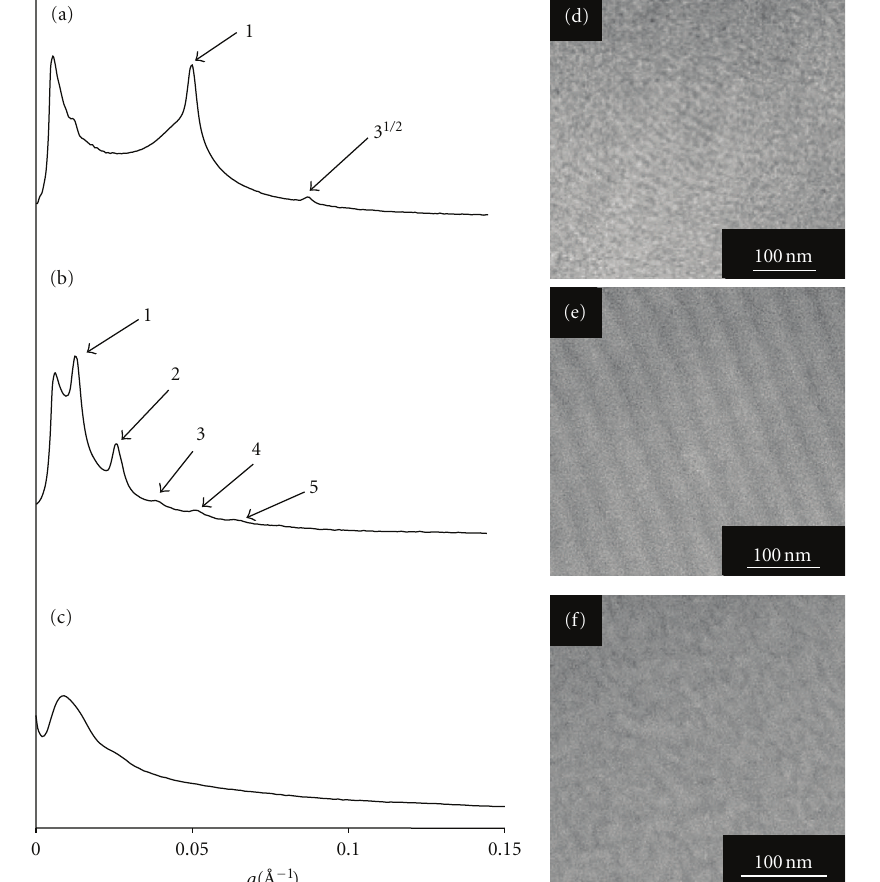
Figure 7: SAXS profiles (a, b, c) and TEM images (d, e, f) of PMAPOSS- b -PMAHFC 1 − 3 ; (a) and (d) PMAPOSS- b -PMAHFC 1 ; (b) and (e) PMAPOSS- b -PMAHFC 2 ; (c) and (f) PMAPOSS- b -PMAHFC 3 . Brighter region corresponds to PMAPOSS domain and darker region corresponds to PMAHFC